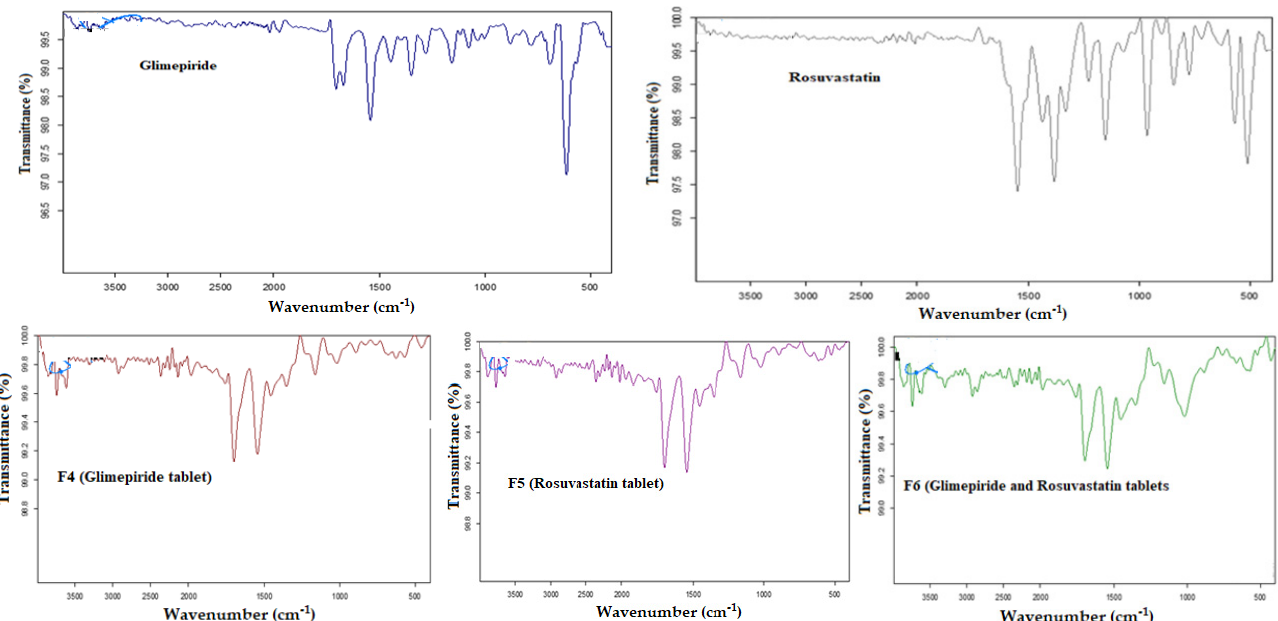
Figure 4. FT-IR spectra of glimepiride, rosuvastatin, and the prepared 3DP tablets.